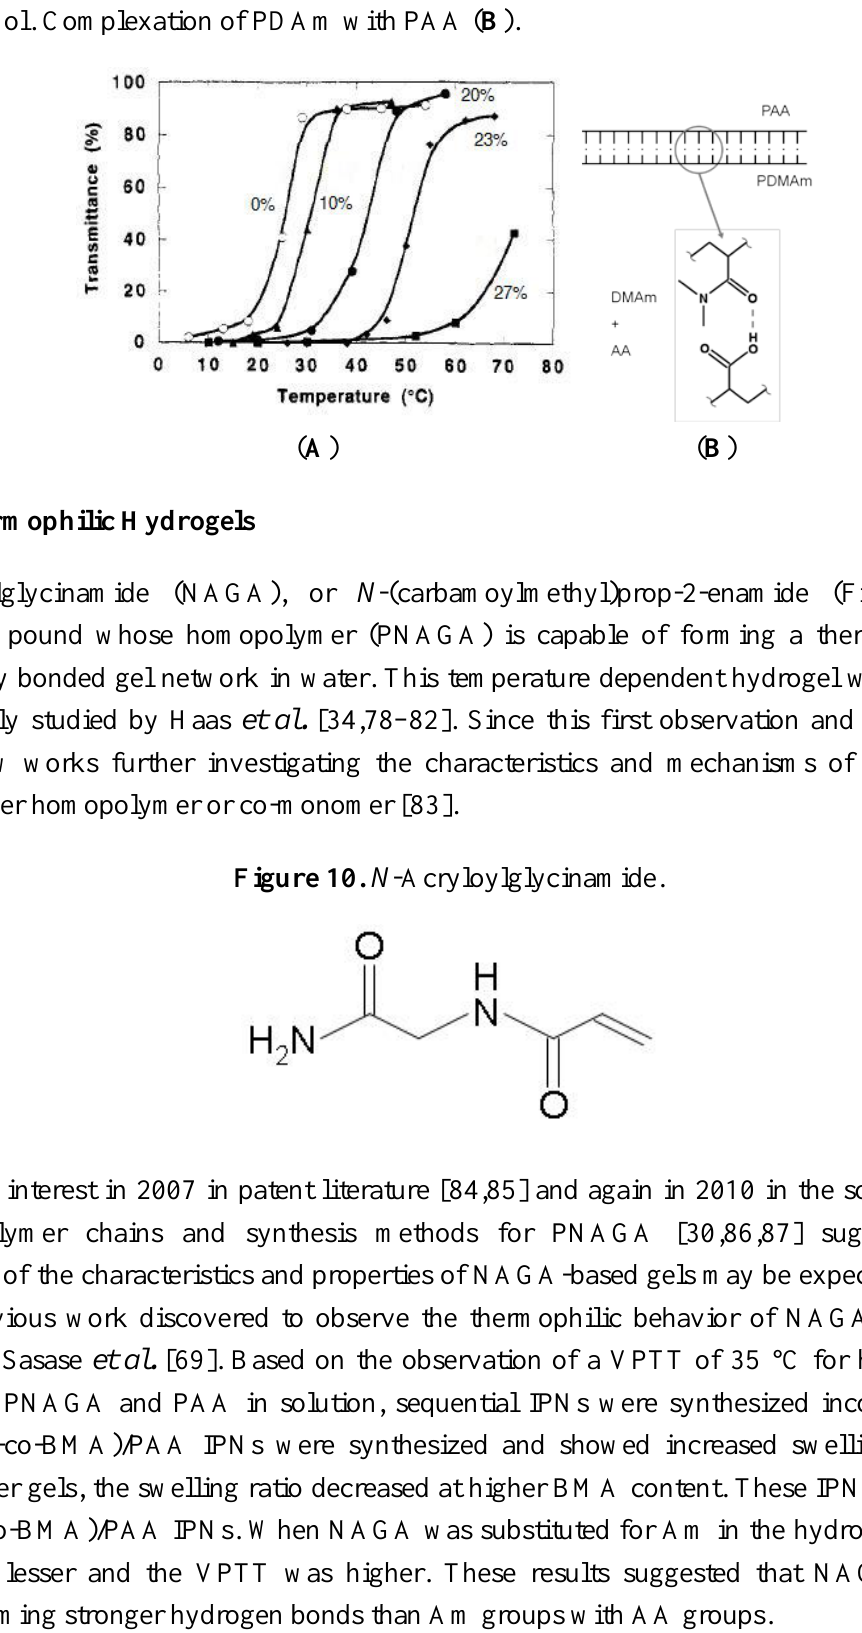
Figure 9. Effect of DMAm content on poly(DMAm-co-Am)/PAA IPN ( A ). Percentages are by mol. Complexation of PDAm with PAA ( B ).